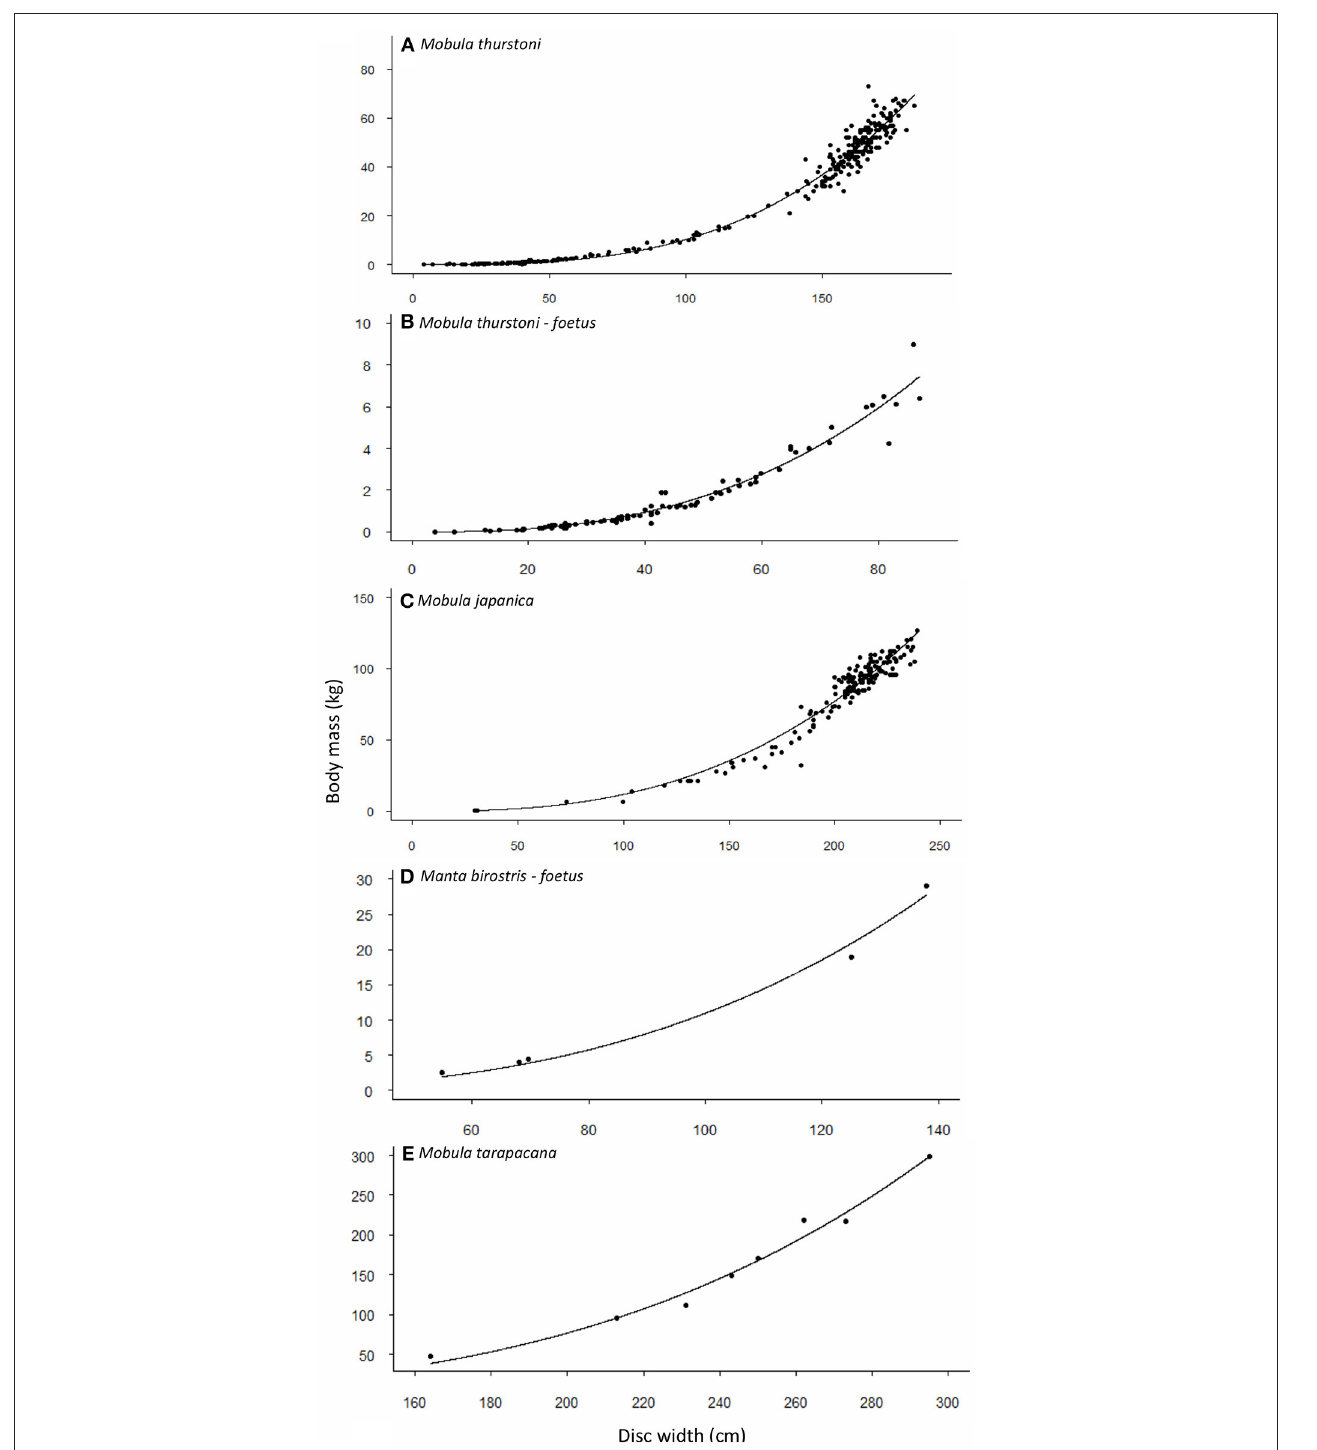
FIGURE 2 | Relationship between body mass and disc width for (A,B) M. thurstoni , (C) M. japanica, (D) M. birostris , and (E) M. tarapacana . Values and parameters estimated for the equation TM = aDW b are summarized in Table 4 .